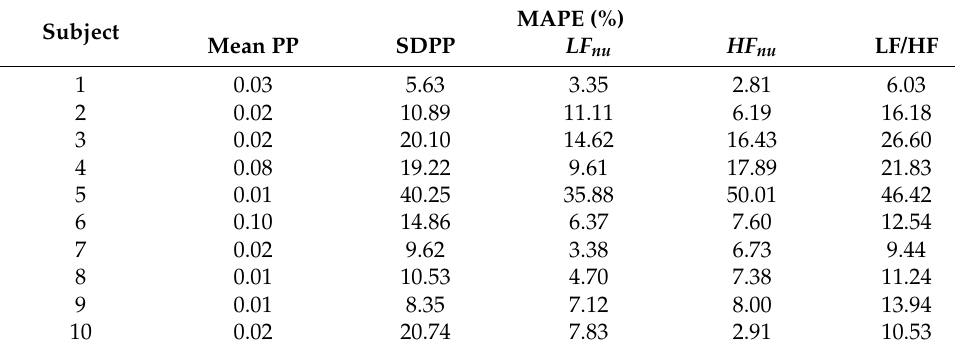
Table 1. Mean absolute percentage error (MAPE) of pulse rate variability (PRV) indicators for peak-to-peak interval (PPI) for subjects studied